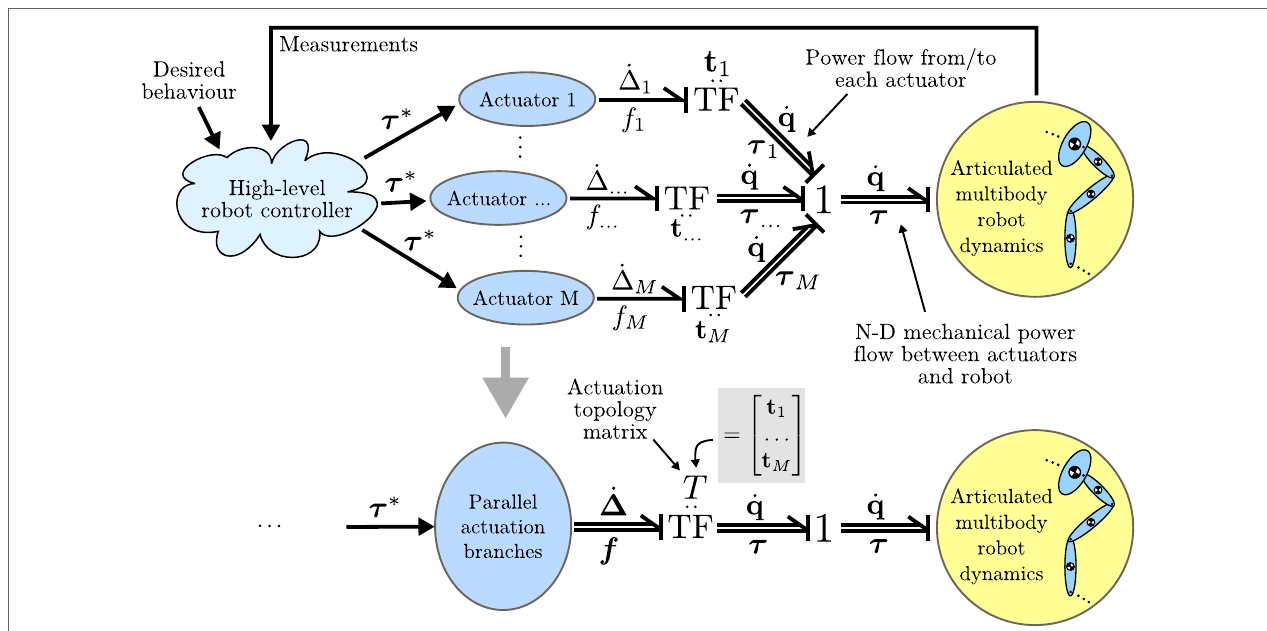
FIGURE 3 | Model formulation using N -dimensional power ports, shown in Bond graph notation. The bottom diagram shows how the actuation topology matrix T describes the power flow between actuators and